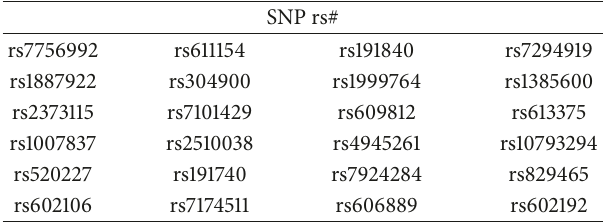
Table 1: 𝐹 1 score comparison between FAACOSE and other meth- ods.